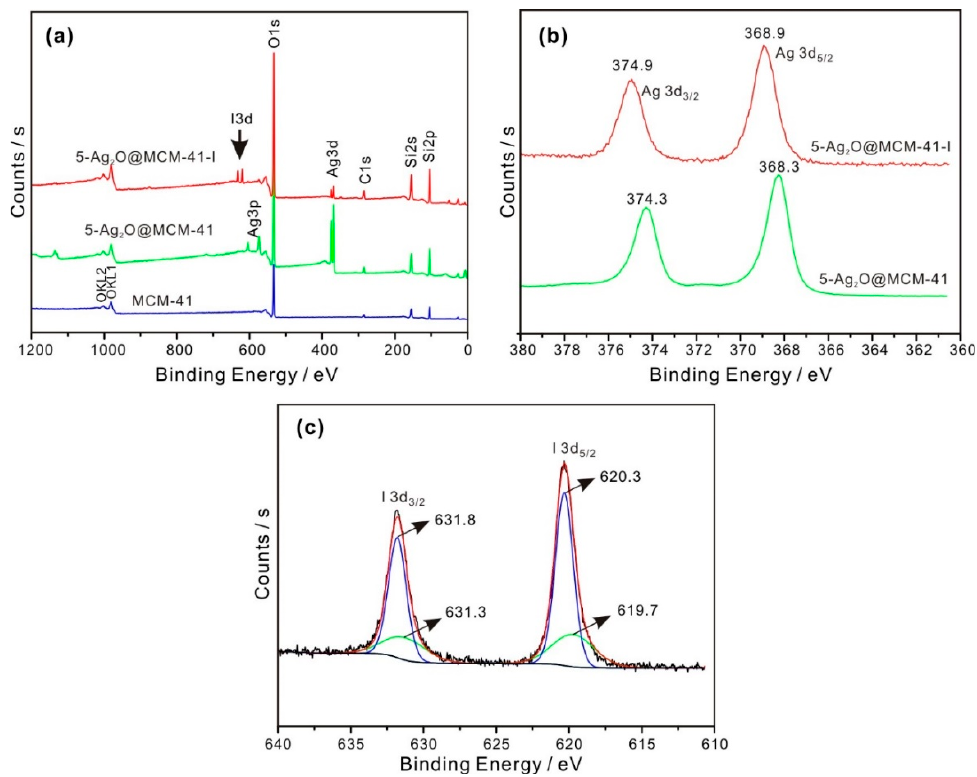
Figure 6. ( a ) XPS survey scan spectra of MCM-41, 5-Ag 2 O@MCM-41, and after its adsorption of I − ; ( b ) high-resolution XPS Ag3d spectra of 5-Ag 2 O@MCM-41 before and after adsorption of I − ; ( c ) high- resolution XPS I3d spectra of 5-Ag 2 O@MCM-41 after adsorption of I − (initial I − concentration, 1.5 mM; 180